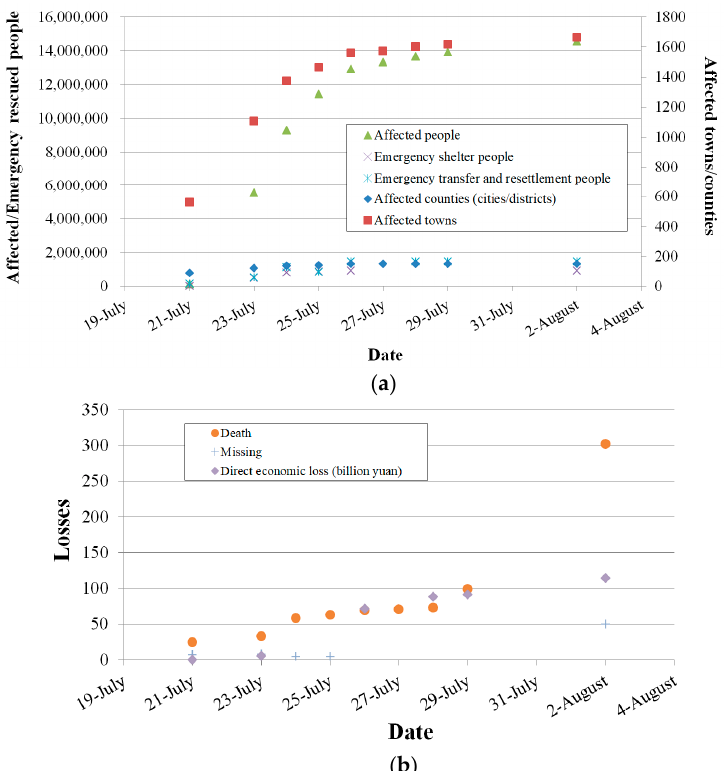
Figure 4. Hotspots regarding the Henan rainstorm from Sina Public Opinion: ( a ) keyword cloud; ( b ) proportion of information by industry.